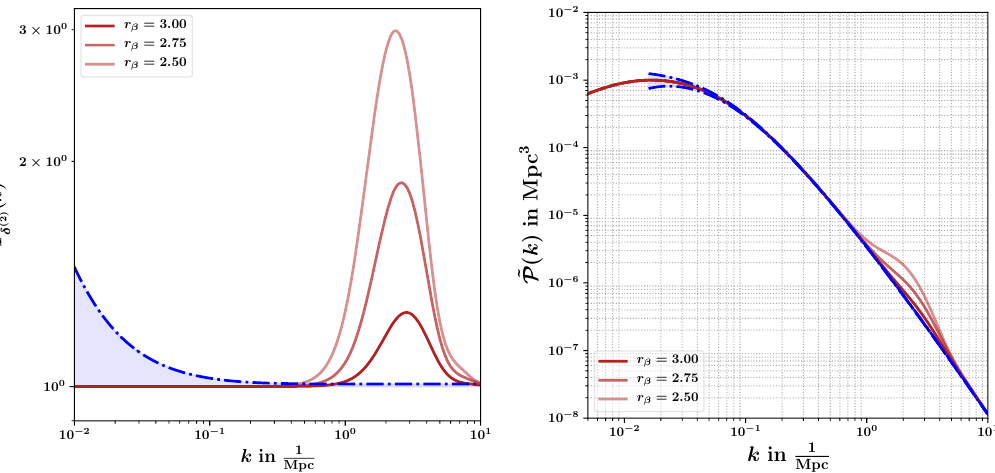
Figure 11: The impact of a late phase transition for different duration ratios r β on the linear matter power spectrum. We chose for each r β a strength α = 3 and fixed the transition time to t ∗ = 5 × 10 9 s,